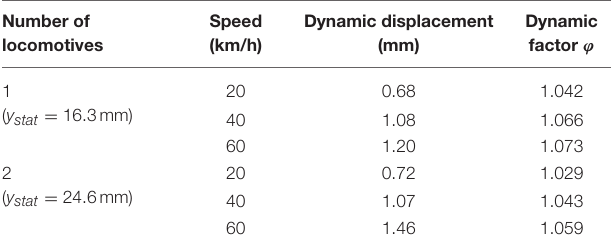
Dynamic factor ϕ